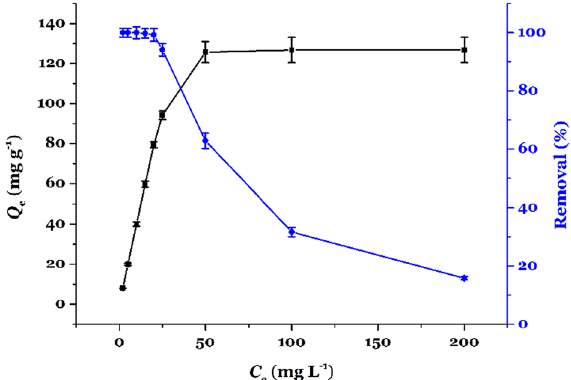
Figure 6. Equilibrium isotherm for adsorption of Hg(II) onto TSF-KCC-1 ( ■ plots are adsorption capacity and plots are removal percentage versus equilibrium concentration, respectively). ●